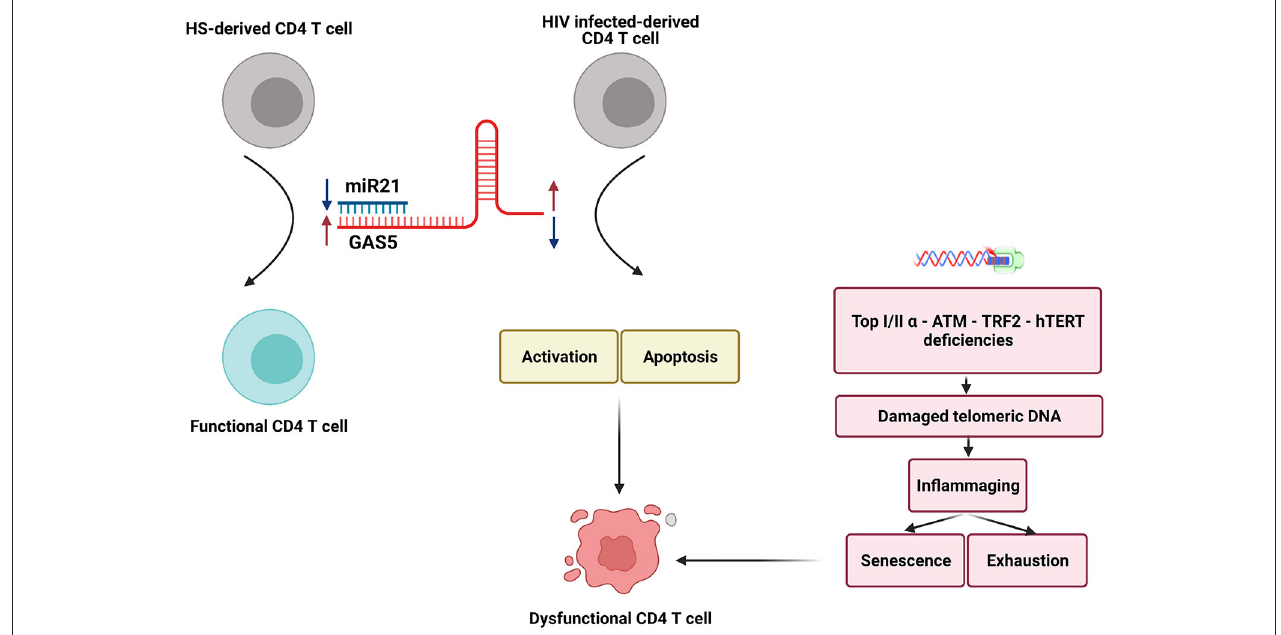
FIGURE 7 | A model depicting how the GAS5-miR-21 axis controls the function and fate of CD4T cells in PLHIV. Two crucial non-coding RNAs, GAS5 and miR-21 are differentially expressed in CD4T cells in PLHIV. The decline in GAS5 and increase in miR-21 expressions, along with the deficiencies in crucial enzymatic proteins involved in DNA damage and repair machineries, can cause significant increases in CD4T cell activation, senescence, apoptosis, DNA damages, and dysregulation of cytokine productions established during latent HIV infection. Importantly, interrupting this GAS5-miR-21 axis may restore T cell homeostasis and competency and resolve premature T cell aging or immune senescence. Notably, GAS5 effects on T cell exhaustion during HIV infection may be mediated by mechanism(s) beyond GAS5-miR21 mediated signaling. Bottom: Deficiencies in Top1/2a, ATM, hTERT, and TRF2 that can cause telomeric DNA damage ( 30–34, 36) are known to contribute to dysfunctional CD4T cells in HIV